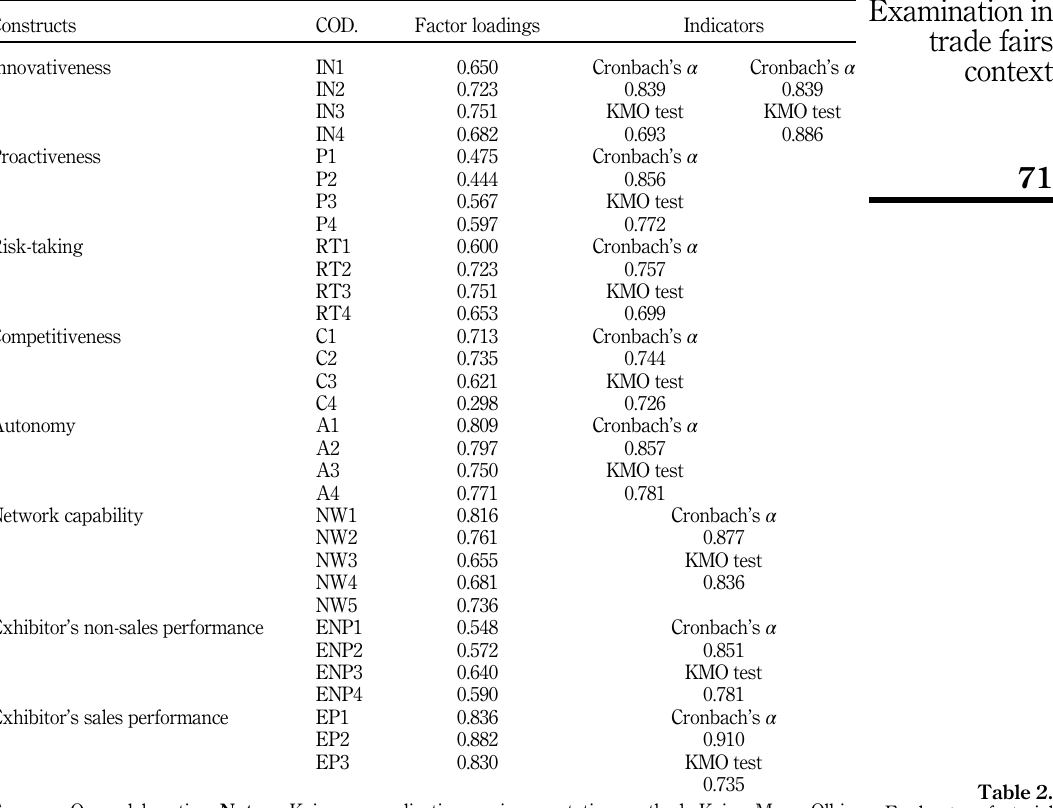
Table 2. Exploratory factorial